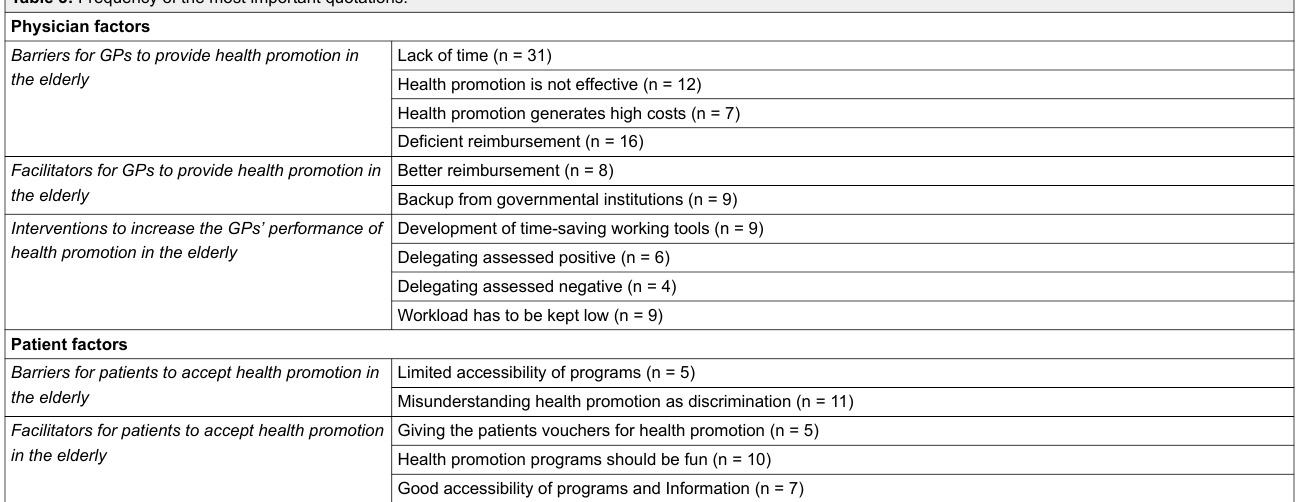
Lack of time (n = 31) Health promotion is not effective (n = 12) Health promotion generates high costs (n = 7)